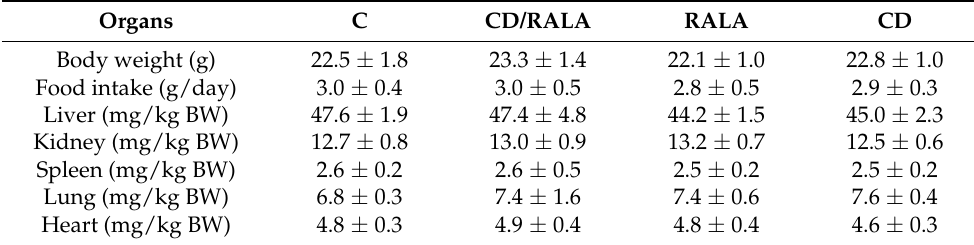
Table 2. General characteristics of animals. Organs